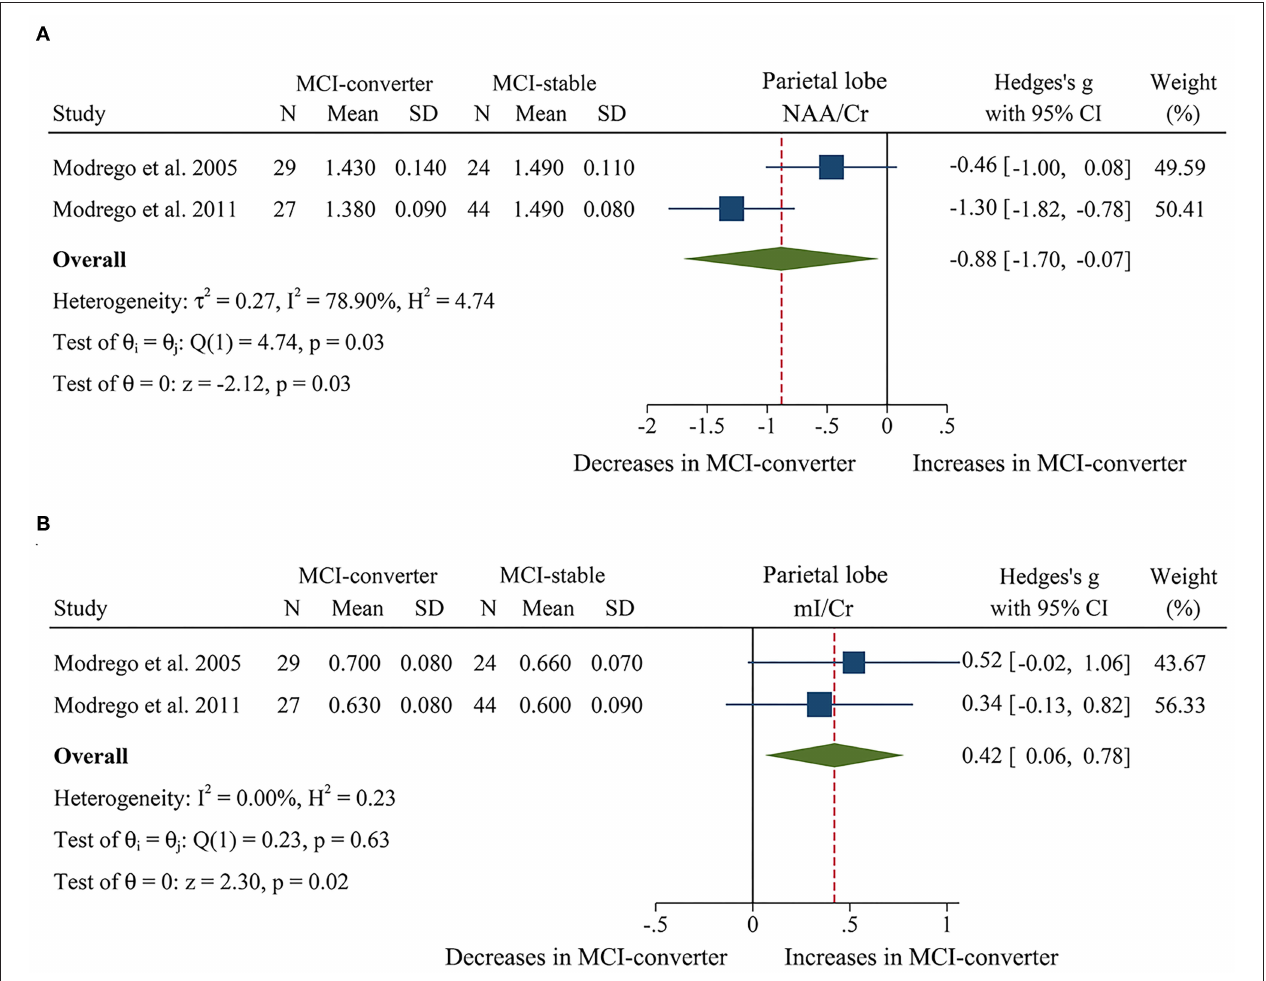
FIGURE 8 | Forest plots show the change of NAA/Cr and mI/Cr in parietal lobe between MCI-converter and MCI-stable patients. (A) Data include 124 individuals from 2 studies for meta-analysis of NAA/Cr levels between MCI-converter and MCI-stable patients. (B) Data include 124 individuals from 2 studies for meta-analysis mI/Cr levels between MCI-converter and MCI-stable patients.